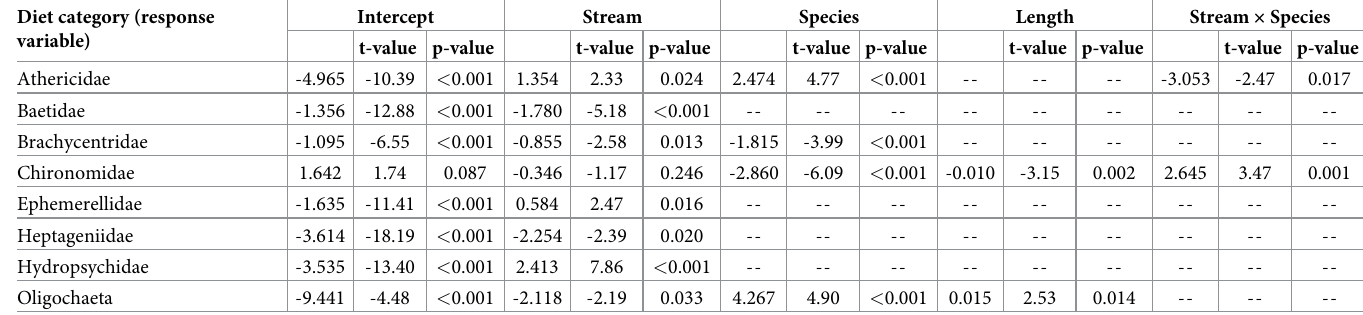
Table 1. Models of eight most consumed diet categories. Summary of model results for the eight most commonly consumed diet categories. Dashes indicate parameters that were not included in the final model. Coefficient estimates, in the first column under each explanatory variable, are reported on the log-odds scale. Baseline categories were Sheep Creek for the stream variable and mountain whitefish for the species variable. Adjusted deviance explained for each model was Athericidae = 0.40, Baeti- dae = 0.40, Brachycentridae = 0.32, Chironomidae = 0.52, Ephemerellidae = 0.08, Heptageniidae = 0.19, Hydropsychidae = 0.57, and Oligochaeta =